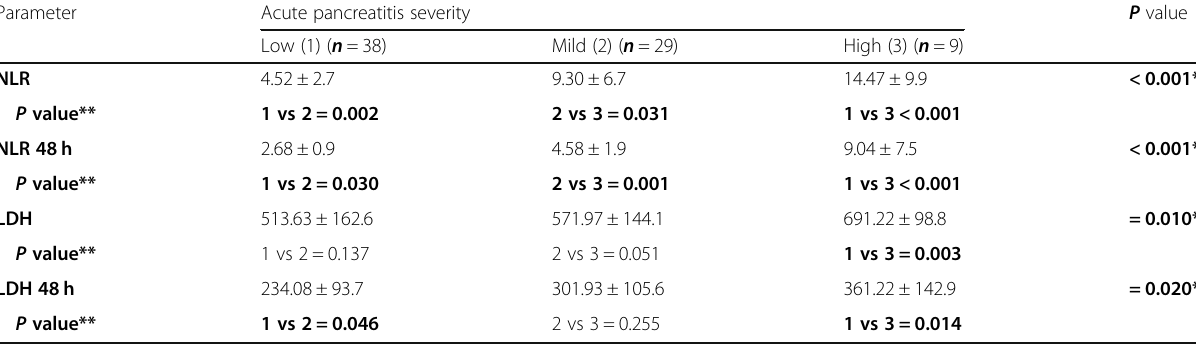
Table 8 NLR and LDH comparison regarding disease severity (calcular)